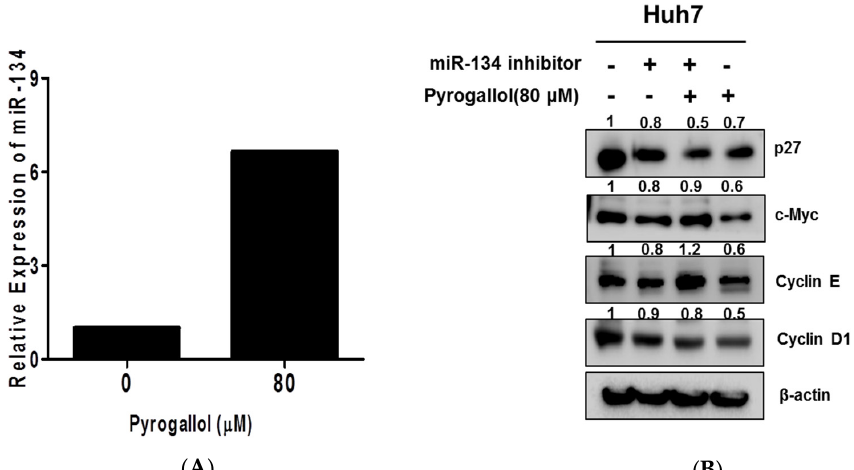
Figure 6. The pivotal role of miR-134 in Pyrogallol-regulated cell cycle-related proteins in Huh7 cells. ( A ) RT-qPCR analyzed the expression of miR-134 levels in Huh7 cells. ( B ) Huh7 cells were transfected with miR-134 for 48 h and exposed to Pyrogallol for 24 h. The expression levels of p27, c-Myc, Cyclin E, and Cyclin D1 were evaluated by Western blotting.